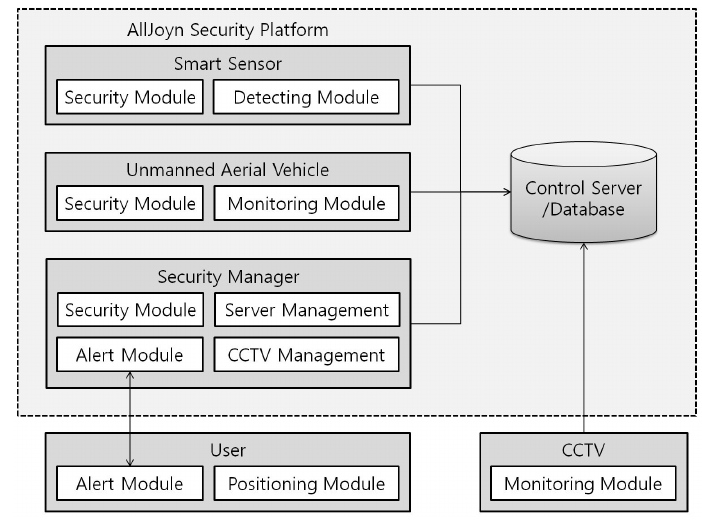
Figure 2. The Main components of the UAV-EMOR